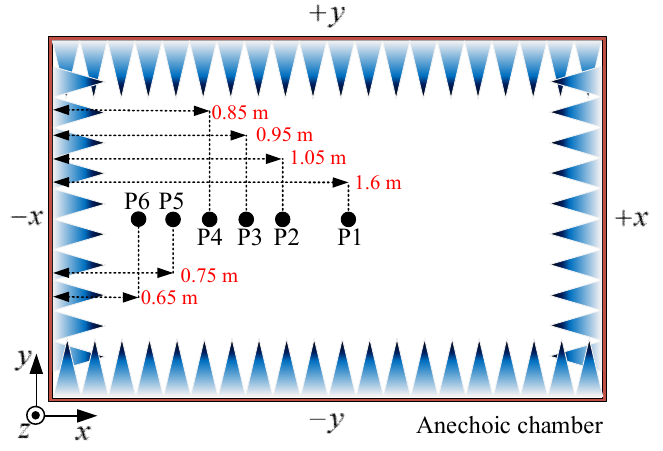
Figure 7. Measurement positions in PIM measurement chamber A. Table 1. Measured results of chamber A at 900 MHz.